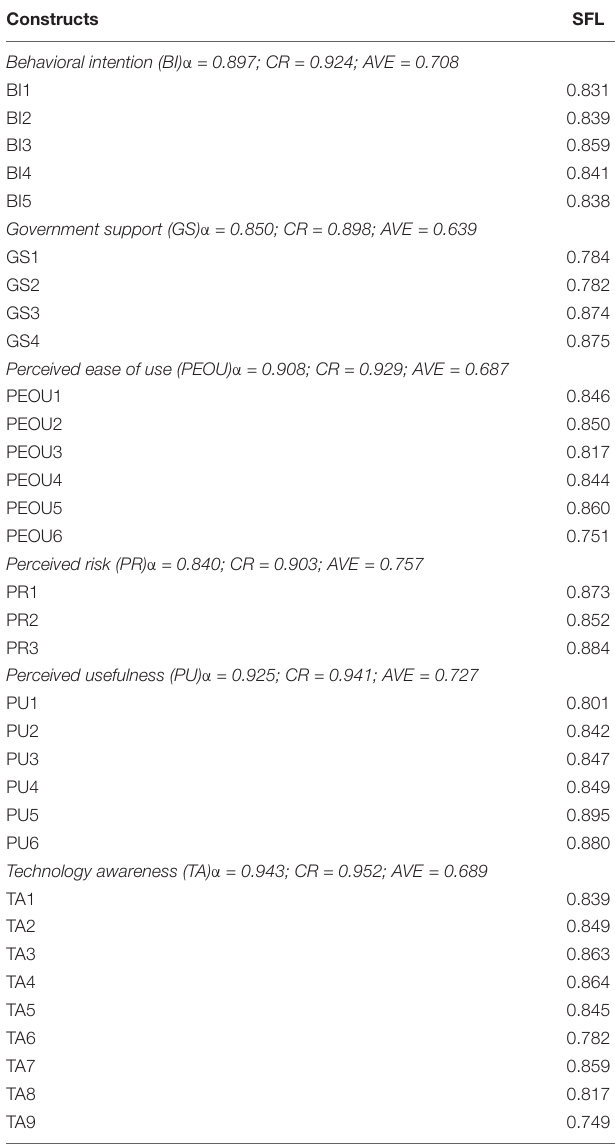
TABLE 2 | Measurement items and standardized factor loadings. Constructs